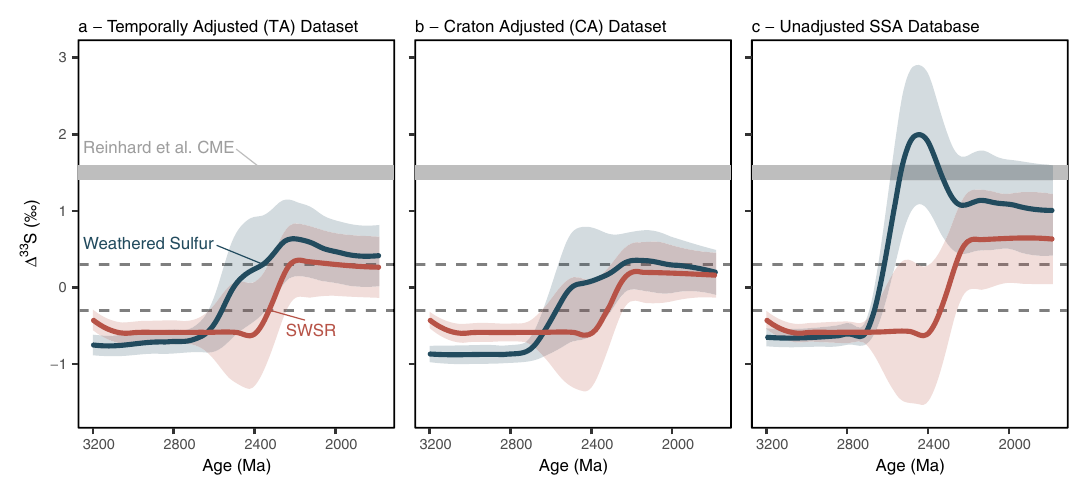
Fig. 3 | The simulated evolution of the crustal memory effect (CME). Here, the presented simulations are derived from exploration of a the Temporally Adjusted (TA), b theCratonAdjusted(CA)and c theunadjustedspotsampleaveraged(SSA) datasets. Colours are common throughout, with blue depicting the Δ 33 S value carried by the weathered sulfur fl ux and orange showing the Δ 33 S composition of